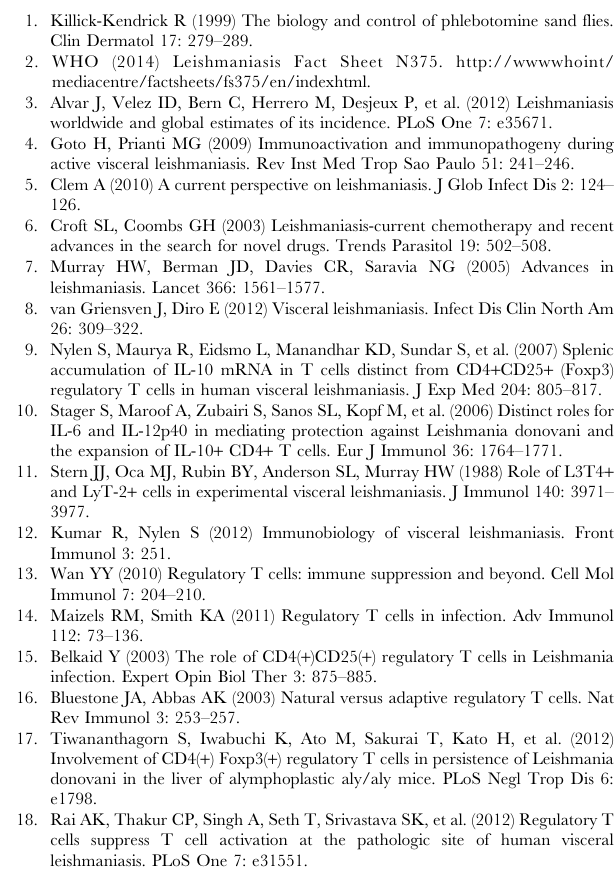
Figure S2 Enhanced resistance of p110 d D910A mice to L. donovani is not due to superior macrophage respon- siveness. Bone marrow-derived macrophages from WT and p110 d D910A mice were infected with L. donovani promastigotes at a cell-to-parasite ratio of 1:5. After 24, 48 and 72 hrs, cytospin preparations were made, stained with Wright-Giemsa stain and the number of parasites per 100 macrophages (A), percent infectivity (B) and number of parasites per infected macrophages (C) were determined. (D) Light microscopy images (at 6 100 (oil) objective) of infected macrophages in different time points. Results are representative of 2 independent experiments (n = 3 mice per group) with similar results. (TIF) Figure S3 Spleen and liver lymphocytes from infected resistant p110 d D910A mice produce less IFN- c than those from WT mice. Spleen (A and B) and liver (C and D) lymphocytes from WT and p110 d D910A mice infected with L. donovani amastigotes were assessed directly ex vivo at 2 and 4 weeks post infection for IFN- c production by flow cytometry. Results are representative of 2 independent experiments (n = 3 mice per group) with similar results. Error bars, + / 2 SEM; *, p , 0.05; **, p , 0.01; ***, p , 0.001. (TIF) Figure S4 Non T cells (CD3 2 ) are the major IL-4- producing cells in the spleens and liver of L. donovani infected WT and resistant p110 d D910A mice. L. donovani promastigote infected p110 d D910A and WT mice were sacrificed at the indicated times and their spleen (A, B) and liver (C, D)